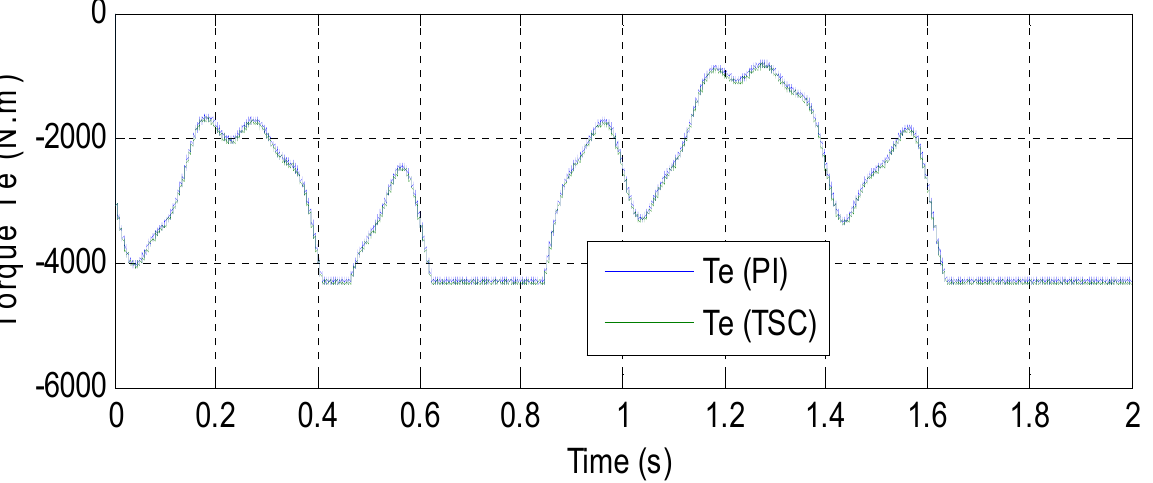
Electronics 2021 , 10 , x FOR PEER REVIEW